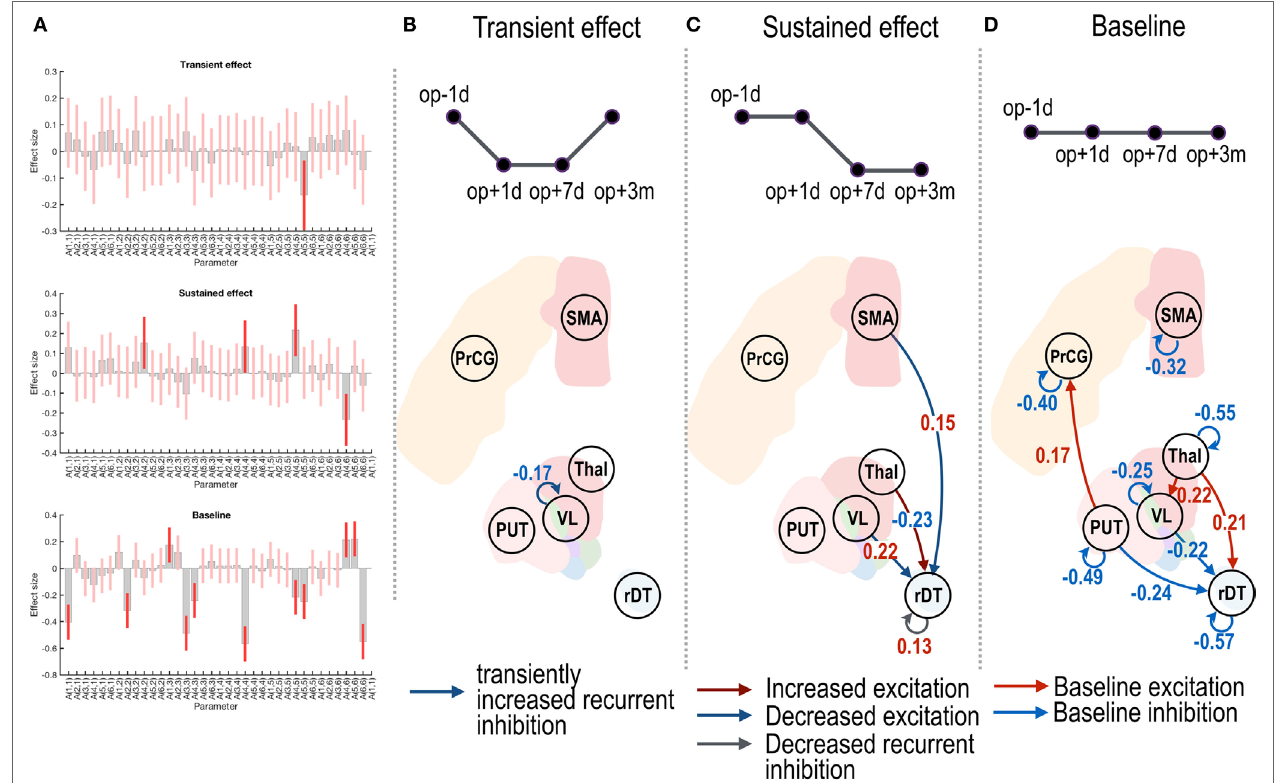
FIgURe 3 | Effective connectivity changes in the motor subnetwork after thalamotomy. The intrinsic effective connectivity associated with treatment, transient, and baseline effect is displayed in the three rows of panel (A) , and from panel (B) to panel (d) . The session regressors for a transient effect ([1 − 1 − 1 1]), a treatment effect ([1 1 − 1 − 1]), and a baseline effect ([1 1 1 1]) are shown in the upper row in panels (B–d) . Effect sizes that survived a non-zero criterion with a posterior confidence of 95% are displayed in the graphs. The self-connectivity in the VL had a negative effect size (B) , indicating a transient change in the effective connectivity. The dark blue and dark red arrows in panel (C) show the positive and negative effect sizes (i.e., blue and red colored numbers) and indicate sustained changes in the effective connectivity (long-lasting increase and decrease in the effective connectivity, respectively). In contrast to the regression analysis in panels (B,C) , the red and blue arrows in panel (d) indicate the group average of baseline positive and negative effective connectivity. VL, ventrolateral thalamic nucleus; PrcG, precentral gyrus; SMA, supplementary motor area; Thal, non-VL thalamic nuclei; Put, putamen in the left hemisphere; rDT, right dentate nucleus in the cerebellum. op − 1d, op + 1d, op + 7d, and op + 3m indicate 1 day before treatment, 1 day, 7 days, and 3 months after